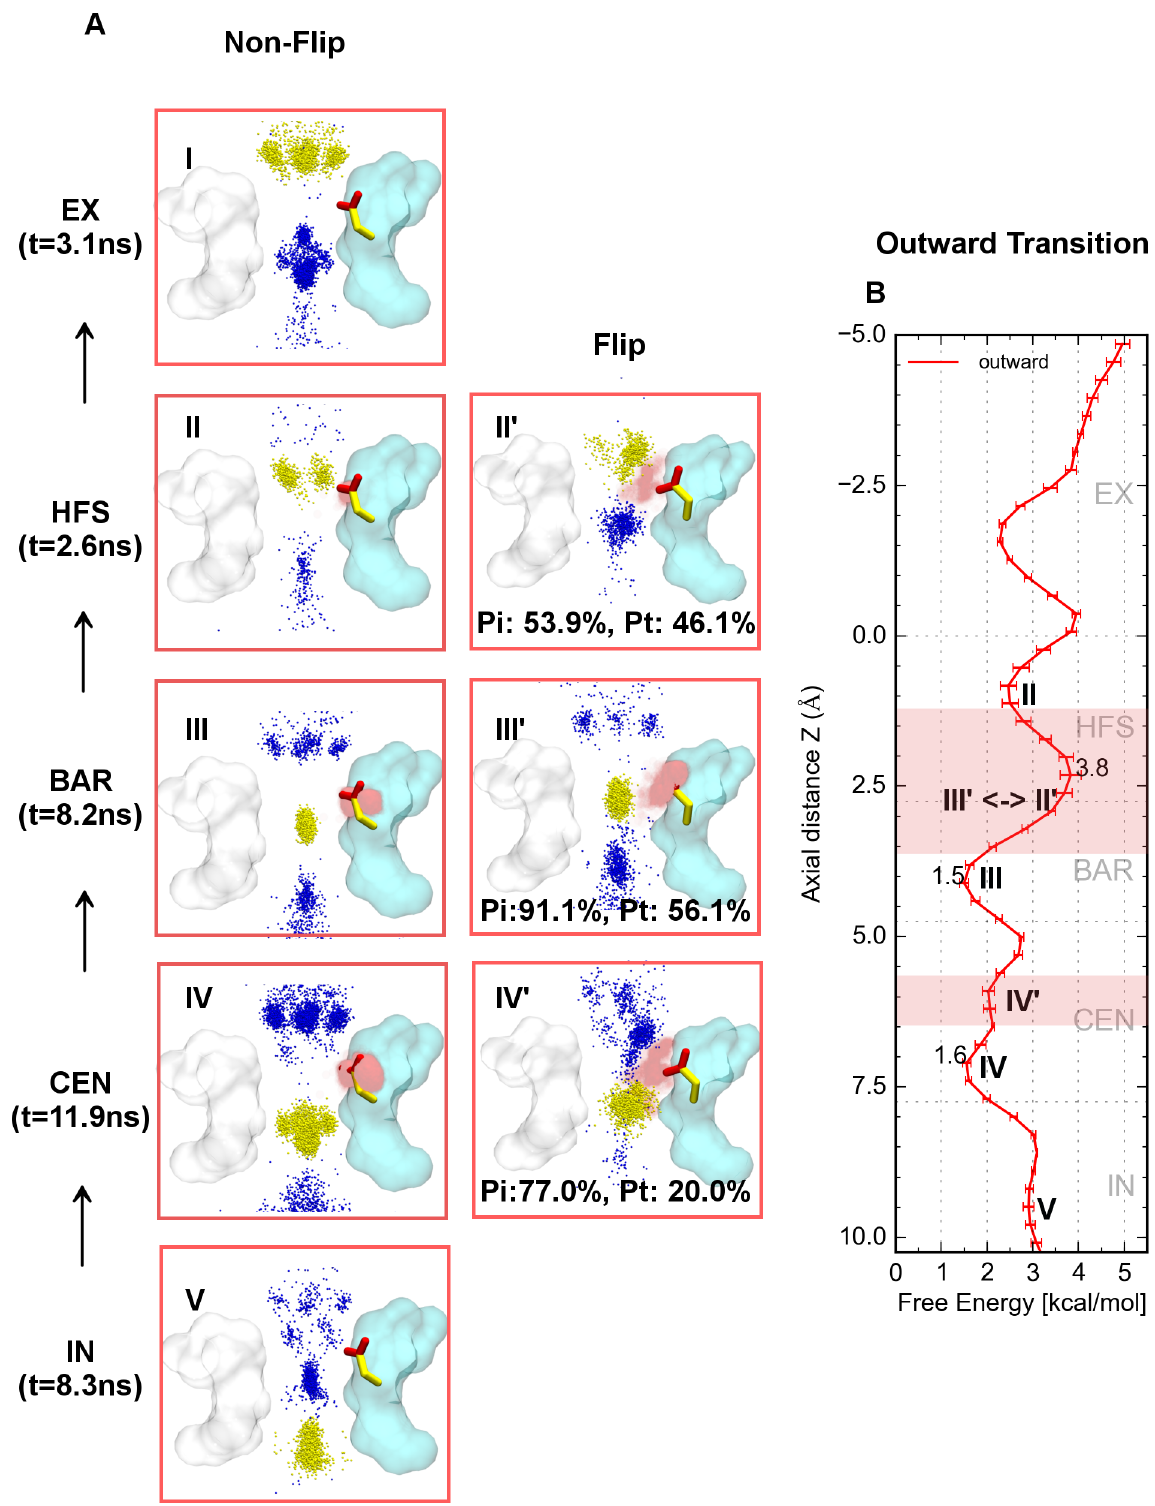
Figure 7. Outward ionic binding modes and PMF. A) Overlay of the conformational space of the probe ions (yellow), coupling sodium ions (blue) and E53 carboxyl oxygen distributions (transparent spheres with different intensity) for different ionic binding modes at different interaction sites. A snapshot of a typical E53 sidechain conformation is shown as stick representation (red, carboxyl oxygens; yellow, sidechain carbons), I–V are non-flip binding modes and II 9 –IV 9 are flipping binding modes for sites S HFS , S BAR and S CEN . Arrows indicate the direction of ion conduction; B) 1-D PMF of outward conduction in SF region, the largest free energy barriers are labeled by terminal peaks and wells, corresponding positions of typical binding modes on the energy profile are labeled. Error estimations shown in the figure are S.E.M.